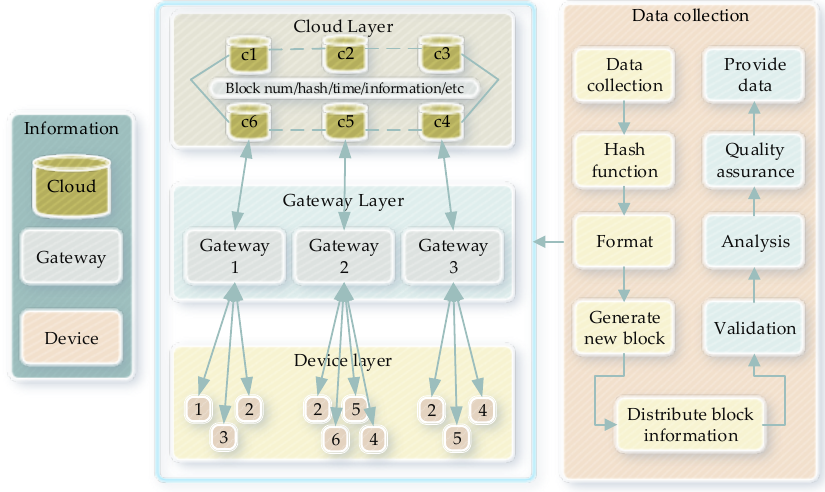
Figure 3. Smart home gateway architecture based on the blockchain cloud-enabled framework.